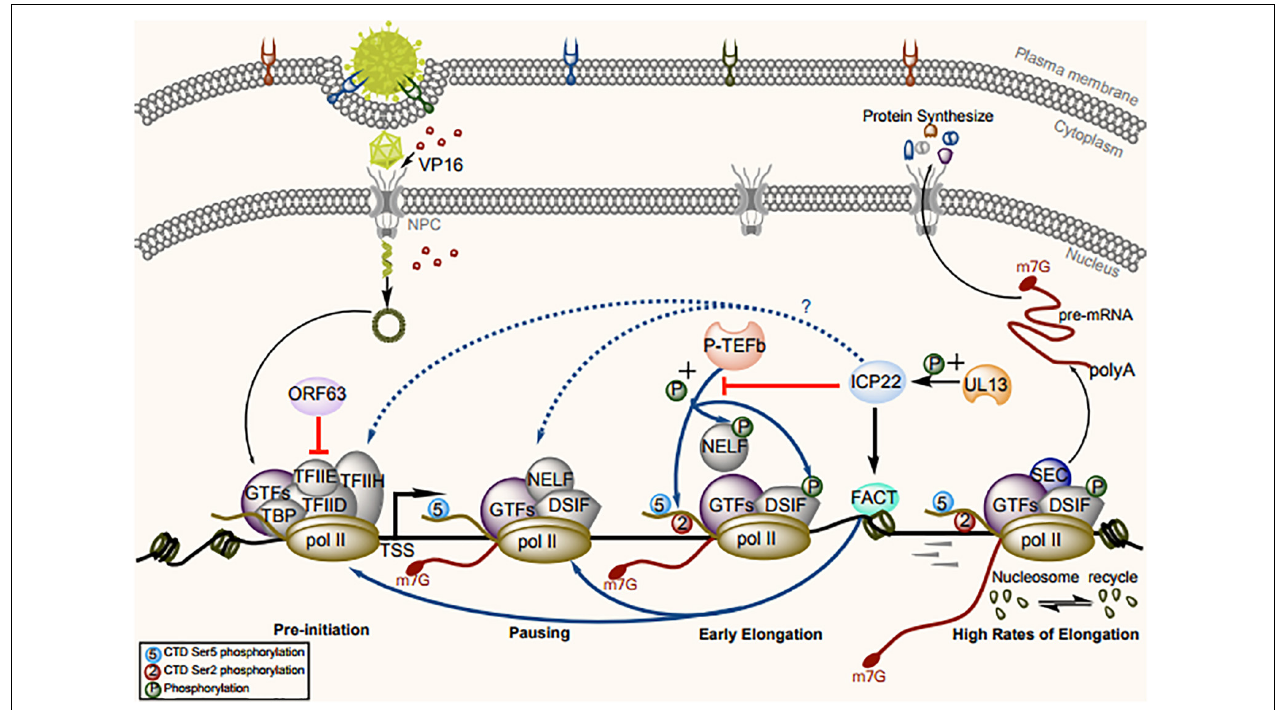
FIGURE 2 | Model for the regulation of RNA pol II–mediated transcription by ICP22/ORF63 and cofactors. Assembly and initiation of the PIC are the first steps in transcription. RNA pol II and GTFs are recruited to the accessible chromatin architecture around the promoter. The CTD of RNA pol II is generally unmodified in the PIC. VZV ORF63 can sequester RNA pol II and TFIIE from promoters to disrupt PIC assembly. After synthesis, a 20- to 60-nt RNA transcript, the pause-inducing factors DSIF and NELF bind the early elongation complex, inhibiting further transcription. The GTF TFIIH complex contains the kinase CDK7, which phosphorylates the RNA pol II CTD at Ser-5, resulting in recruitment of the capping enzyme complex to add a 5 (cid:48) cap to the nascent RNA. The release of paused RNA pol II is triggered after phosphorylation of RNA pol II CTD Ser-2 and pause-inducing factors by P-TEFb, to dissociate NELF and promote productive elongation. At this stage, ICP22 can trigger loss of phosphorylation of Ser-2 in the RNA pol II CTD by interacting with P-TEFb, and VP16 can recruit P-TEFb into the viral promoter region, thus offsetting ICP22-mediated inhibition of transcription. During elongation, ICP22 can interact with the FACT complex to promote the production of viral progeny by ensuring looser chromatin architecture on viral gene